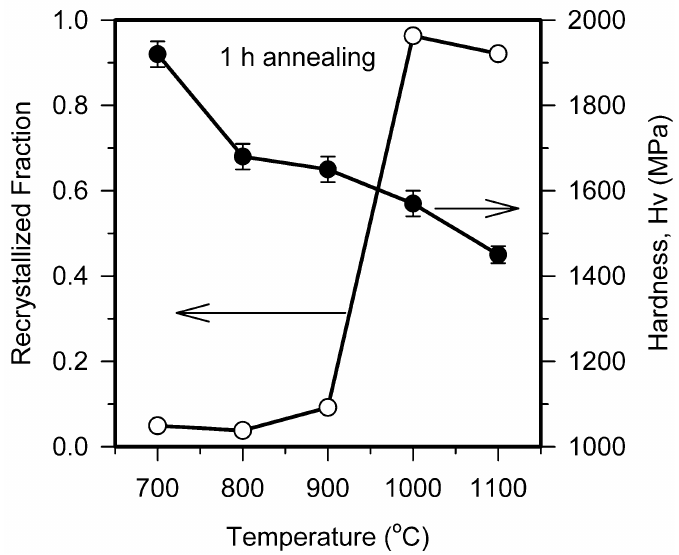
Figure 2. Recrystallized fraction calculated as the area fraction of grains with grain orientation spread below 1 ◦ and the hardness of the steel samples subjected to 5% cold rolling reduction followed by 1 h of annealing.